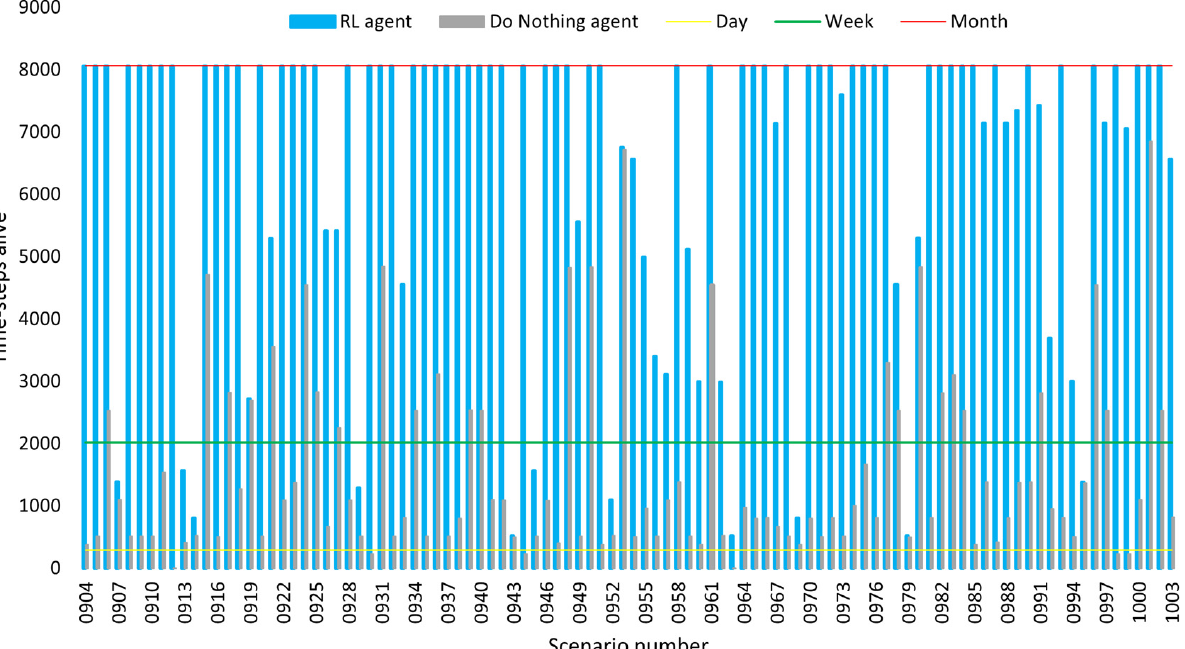
Figure 8. Performance of RL agent in 100 test scenarios.